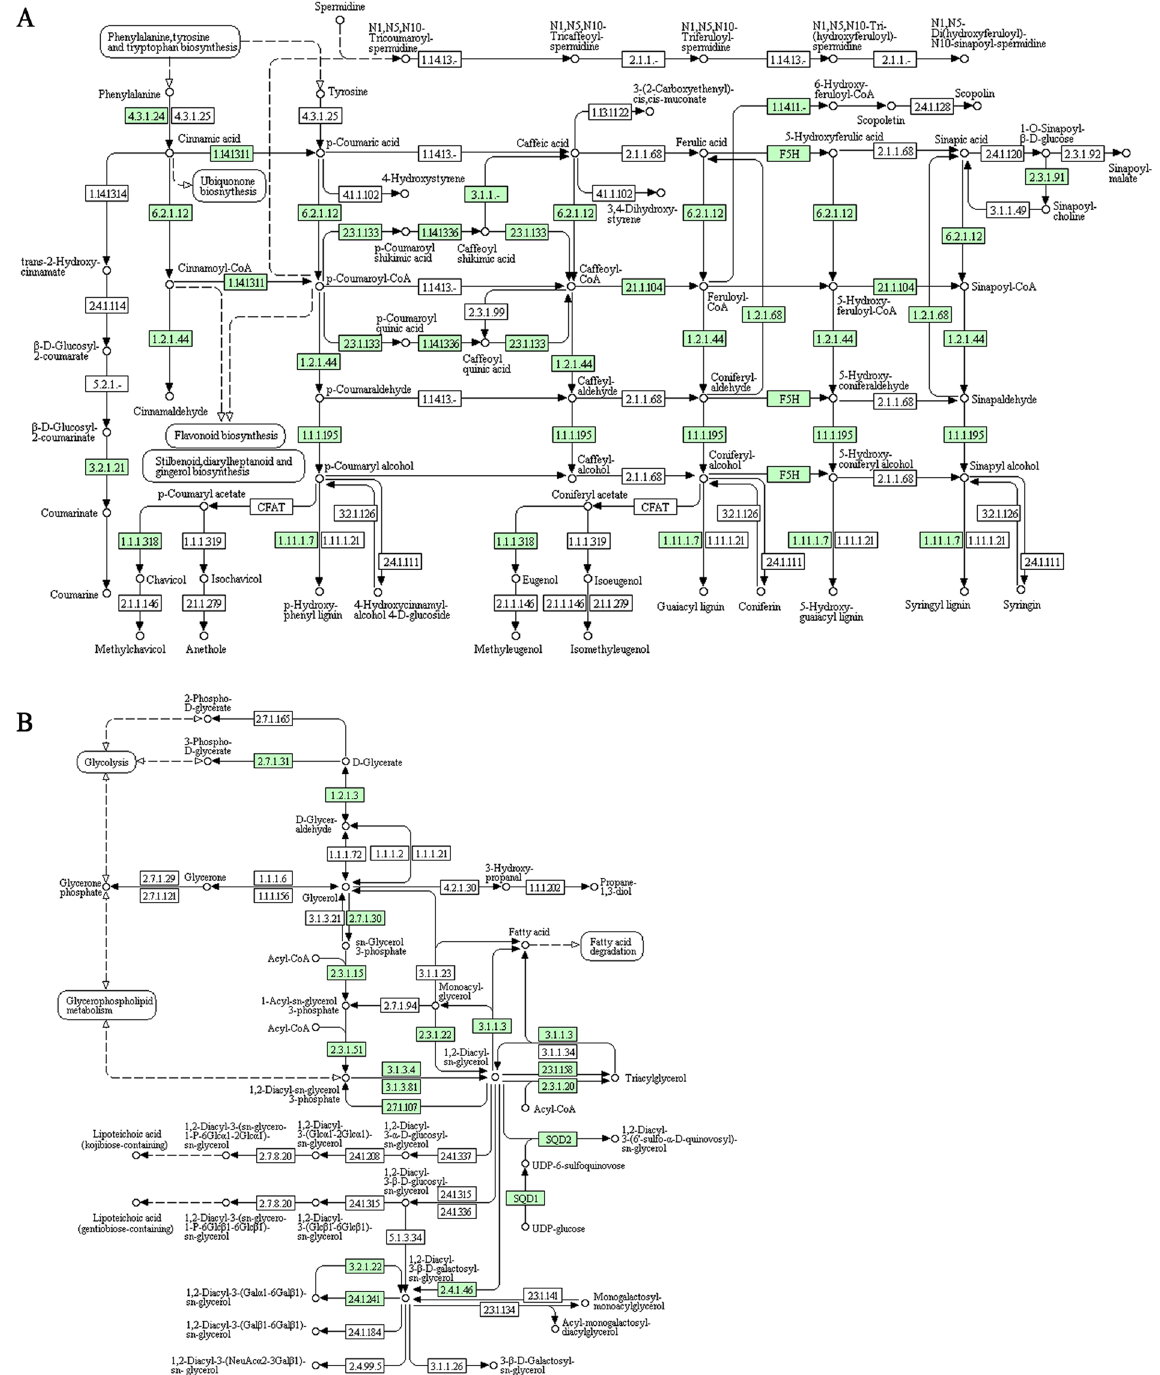
Figure 5. KEGG analysis showing genes involved in phenylpropanoid biosynthesis ( A ) and glycerolipid metabolism ( B ) in Capparis spinosa leaf transcriptome (Enzyme Code - EC - identified are in